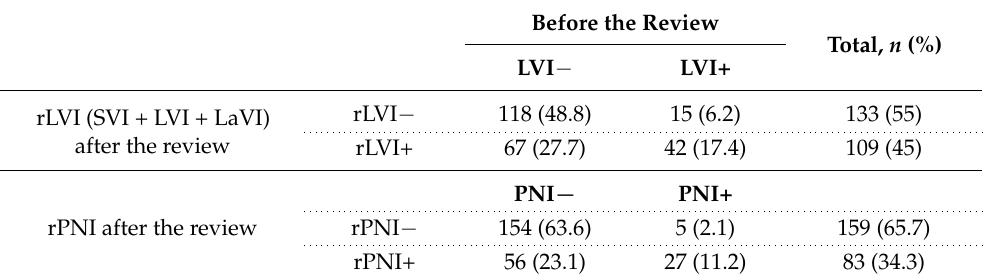
Table 4. Changes in the diagnosis of LVI and PNI in the review cohort.